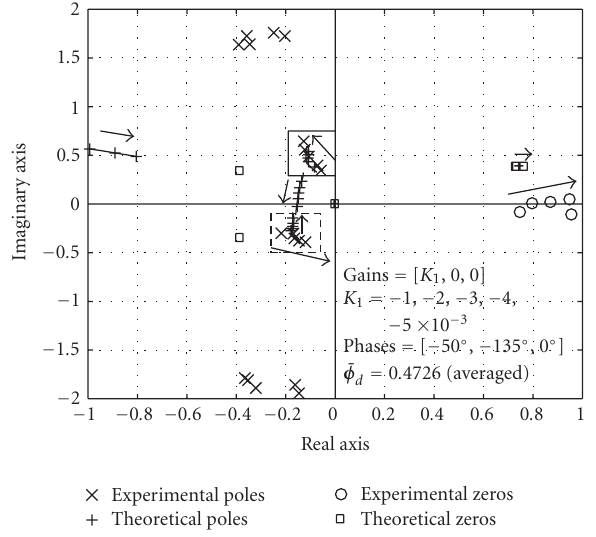
Figure 13: Closed-loop root locus for harmonic 1 with varying